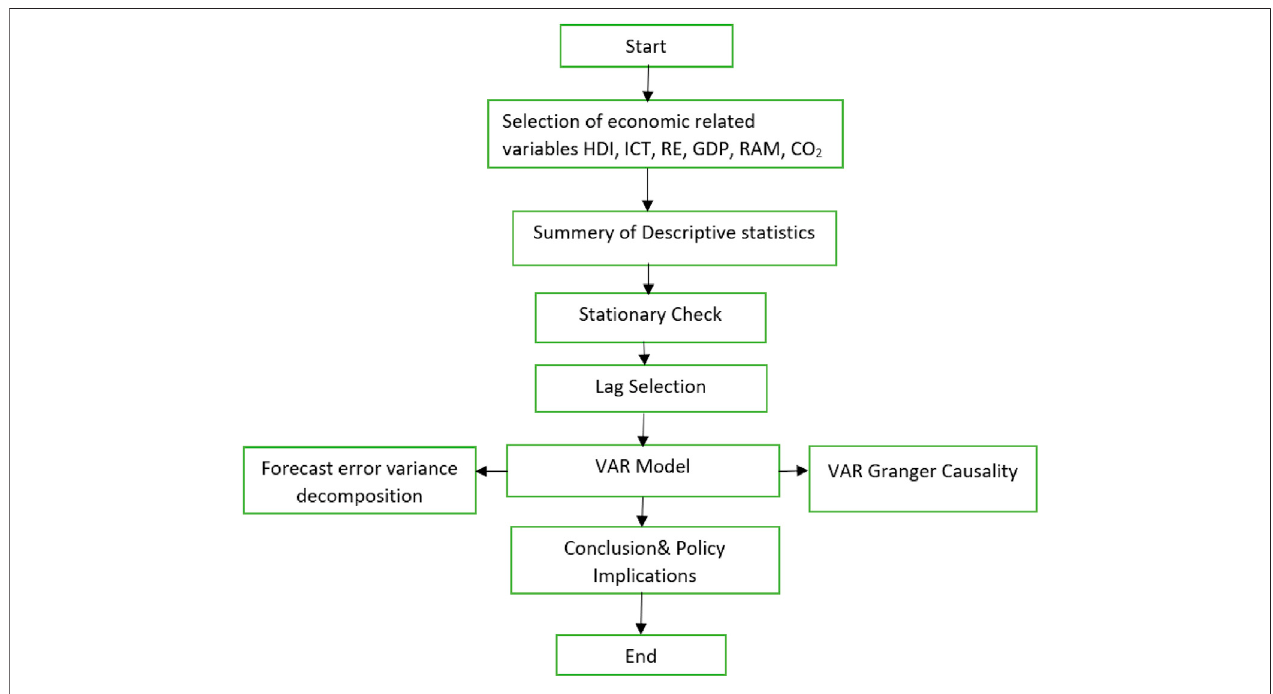
FIGURE 1 | Theoretical Model of the estimation strategy.